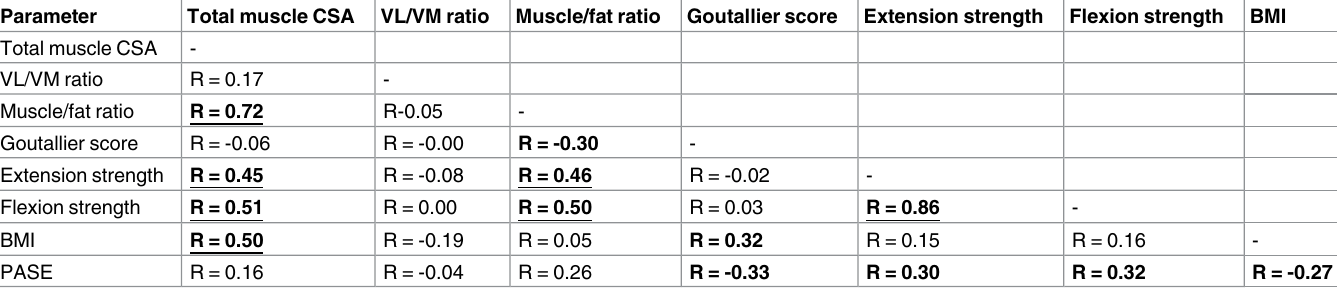
Table 3. Pearson correlations.